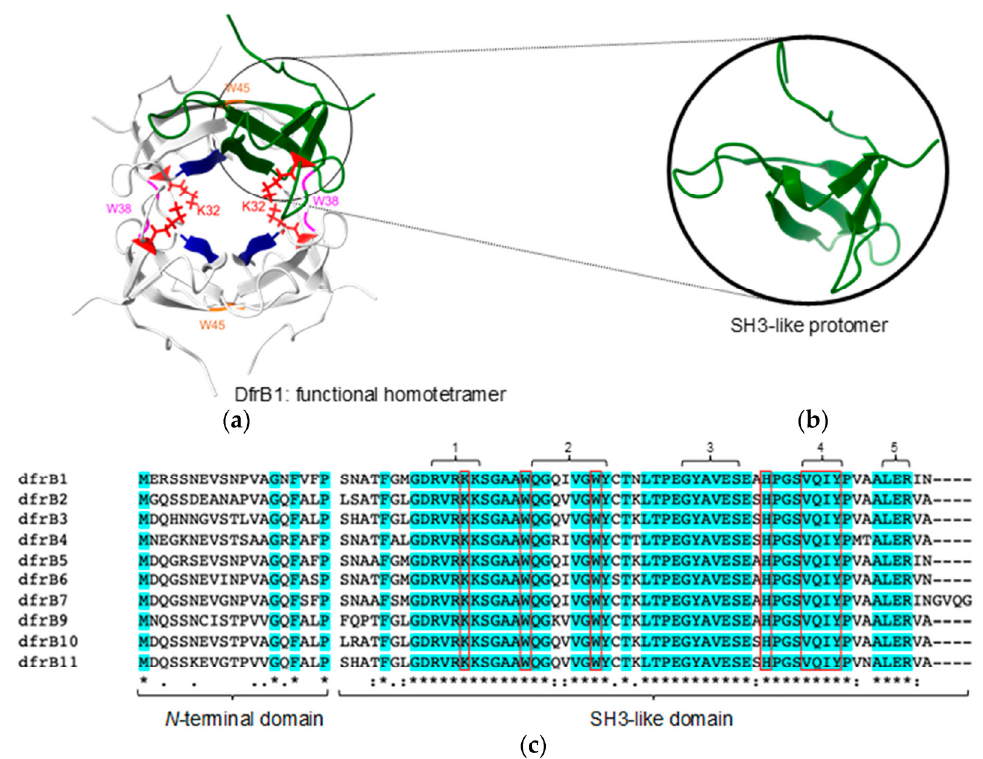
Figure 1. Structure of DfrB1 and sequence alignment of the known DfrB family members (75–95% sequence identity). ( a ) The functional, homotetrameric DfrB1 (PDB 1VIE) is constituted of four identical SH3-like protomers (one shown in green) that form the single, central active-site tunnel. The VQIY catalytic tetrad (V66, Q67, I68, and Y69; dark blue) and key residues K32 (red), W38 (magenta) and W45 (orange), are identified. ( b ) The DfrB1 protomer adopts an SH3-like fold. ( c ) Multiple sequence alignment of DfrB1–DfrB11 (there is no DfrB8) shows amino acid conservation, using standard annotation beneath the alignment. Conserved residues are highlighted in cyan. The poorly conserved N -terminal domain and the highly conserved SH3-like domain are identified. Functionally and structurally important residues are framed in red.